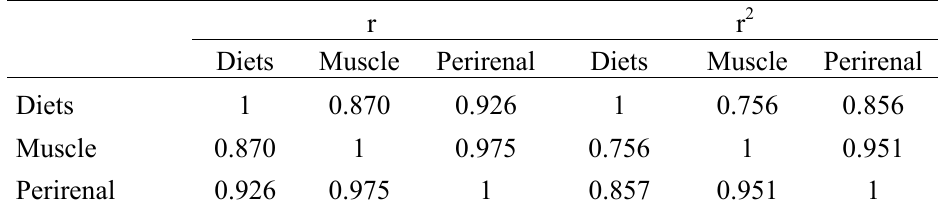
Table 5. Pearson correlations between the FA averages of the experimental groups. r r 2 Diets